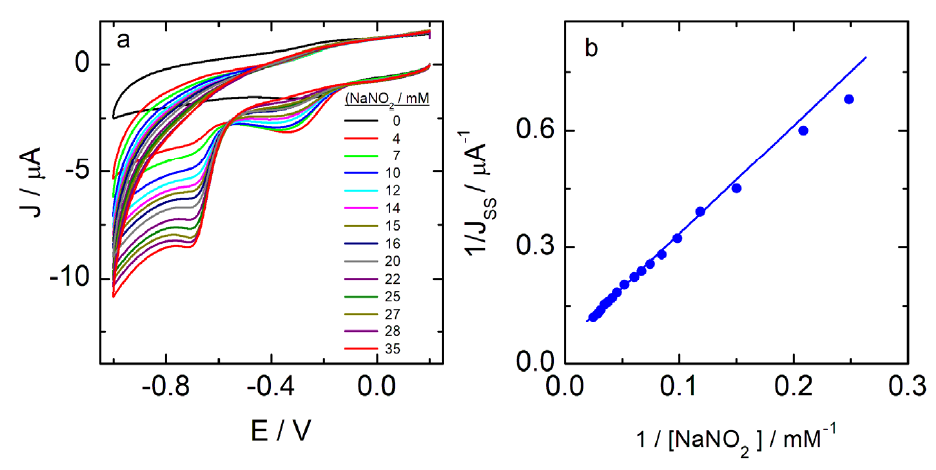
Figure 6. ( a ) Cyclic voltammograms for the electrocatalytic response of the Hb-AuNTs system for nitrite ions detection. The voltammograms were recorded after multiple standard additions of NaNO 2 solution to a 10 mM phosphate buffer solution at pH 5; ( b ) Lineweaver–Burk plot. Table 2. Electrocatalytic parameters determined for H 2 O 2 and NO 2- analytes in the presence of heme- based bioconjugates dropped in a GC electrode.